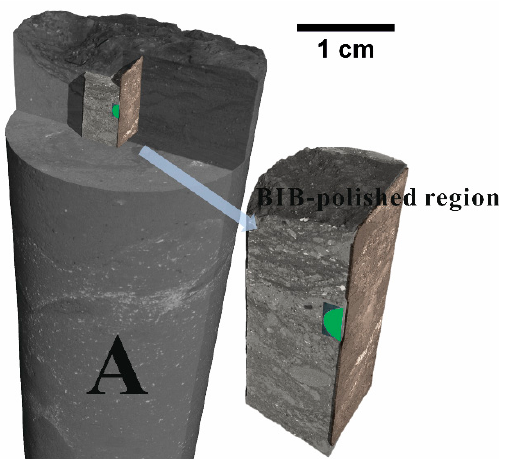
Figure 1. Rendered X-ray micro-CT images of cylindrical sample A and the corresponding micro- core used for BIB-SEM and FIB-SEM experiments (the green region is the BIB-polished area). used for BIB-SEM and FIB-SEM experiments (the green region is the BIB-polished